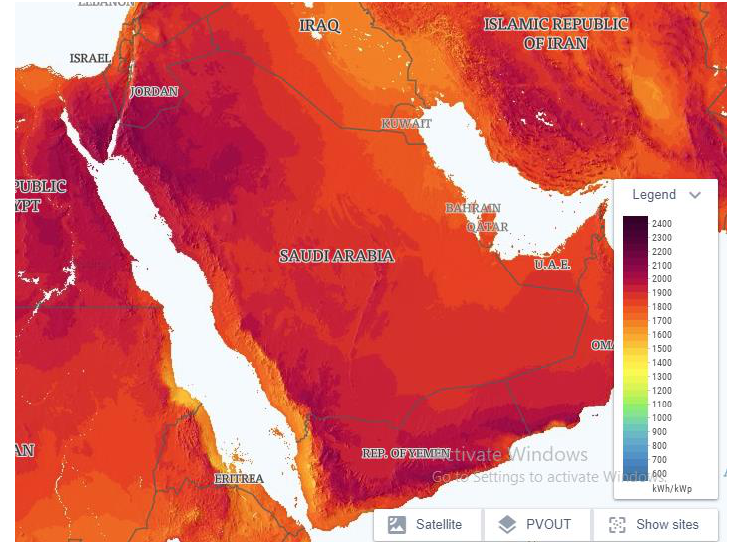
Figure 4. Solar atlas of Saudi Arabia, https://globalsolaratlas.info/.